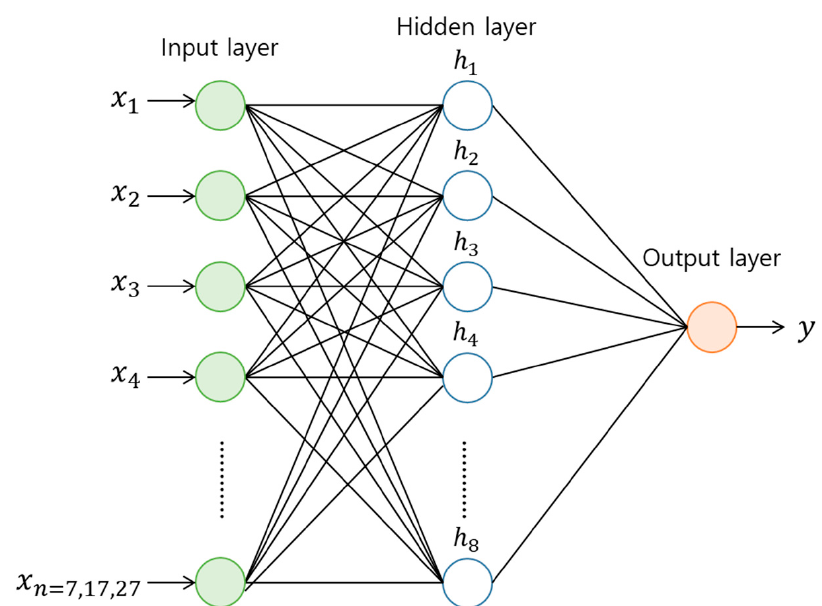
Figure 4. Structure of the ANN process.